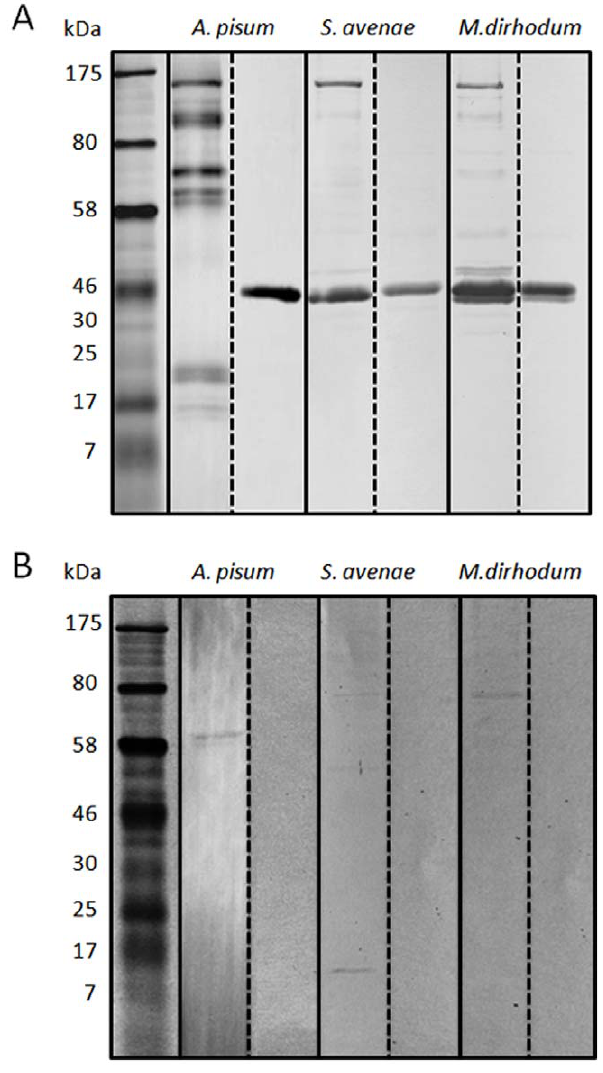
Figure 3. Immunoblotting of secreted salivary proteins from A. pisum , S.avenae and M.dirhodum using polyclonal antibodies raised against (A) ACYPI009881 and (B) saliva-associated GLD. Two parallel blots are shown for each aphid saliva/antibody combina- tion; the left hand blot represents antibody-protein interactions whereas the right hand blot represents binding of the antibody after incubation with the immunizing peptide to demonstrate non-specific binding of the primary and/or secondary antibody. Blots in (B) were overexposed to visualise the faint bands representing antibody binding to saliva-associated